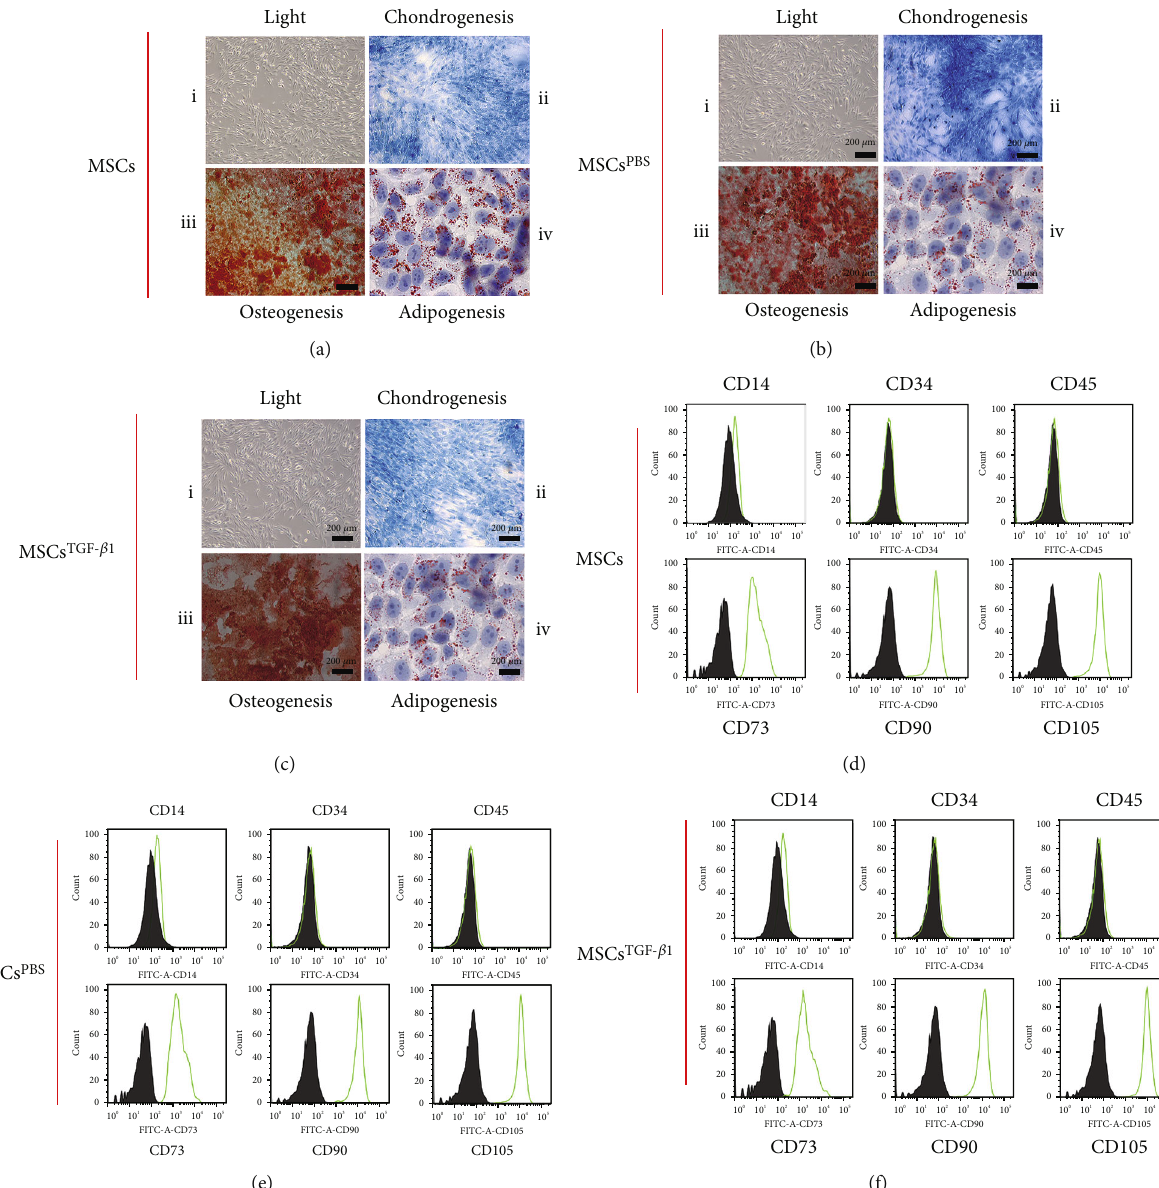
Figure 1: Characterization and di ff erentiation potentials of cultured MSCs. (a) MSCs showed morphology consistent with typical MSCs (i) and could successfully di ff erentiate into osteoblasts (ii), chondrocytes (iii), and adipocytes (iv), n = 3 . (b, c) MSC PBS and MSC TGF- β 1 morphology was similar to normal MSCs (i) and could di ff erentiate into osteoblasts (ii), chondrocytes (iii), and adipocytes (iv), n = 3 . (d – f) Cultured MSCs were immunostained with antibodies for CD73, D90, and CD105 (positive) and CD14, CD34, and CD45 (negative). The stained cells were analyzed using fl ow cytometry to detect the surface markers speci fi c to MSCs. The percentage of the cell population with positive or negative staining is represented in each fi gure, n = 3 . MSCs: mesenchymal stem